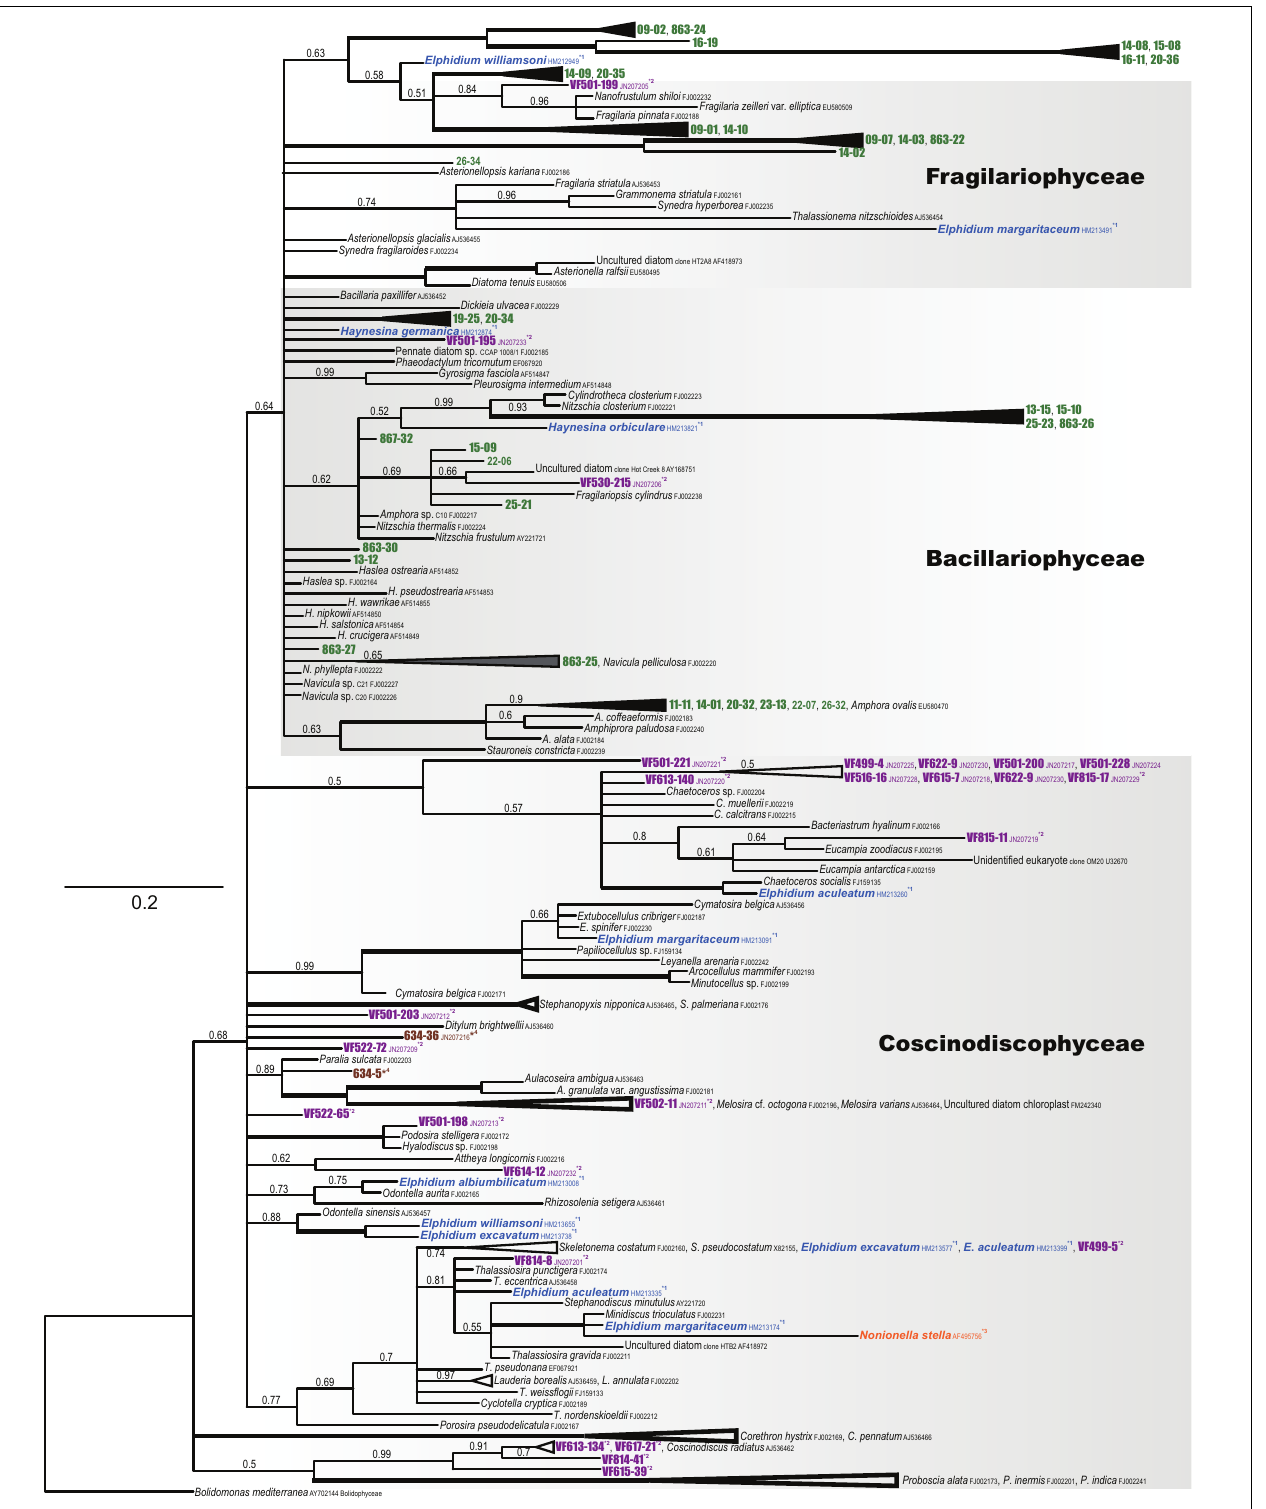
FIGURE 4 | Phylogenetic tree of plastid 16S rRNA (diatom) based on Bayesian inference (MrBayes). Numbers above the internal branches at the nodes indicate the posterior probabilities. Accession numbers follow the species names. Bolidomonas mediterranea (AY702144) was used as the outgroup. Kleptoplasts of P . opercularis are shown in green; reference kleptoplasts of Virgulinella fragilis (purple), Elphidium species, Haynesina species (blue), Nonionella stella (orange), and environmental DNA (brown) are also indicated.